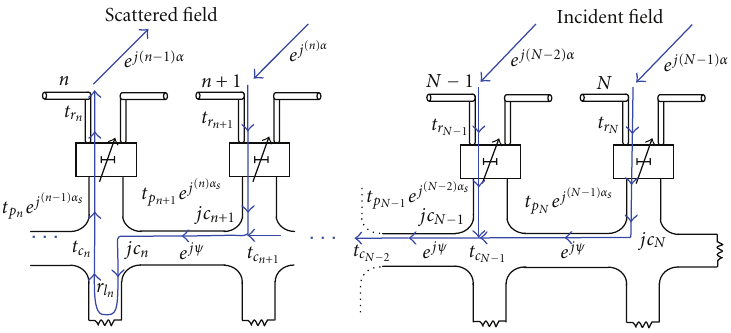
Figure 8: Path of the signal traveling towards the n th element from the next ( N − n ) elements. The scattered field at the same element n may also be a ff ected by the signals, which travel from the previous n − 1 elements of the array towards it. The path of such a signal is shown in Figure